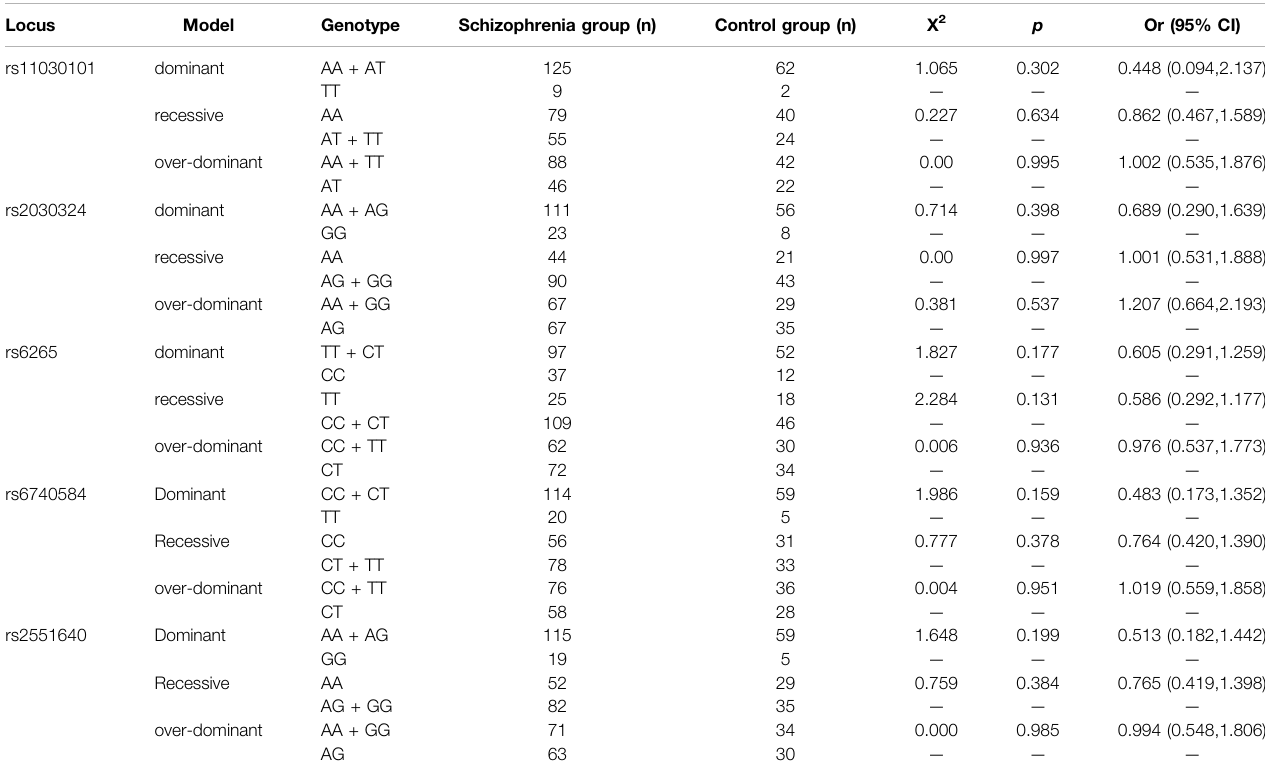
TABLE 6 | Genetic model distribution between two groups (n). Locus Model